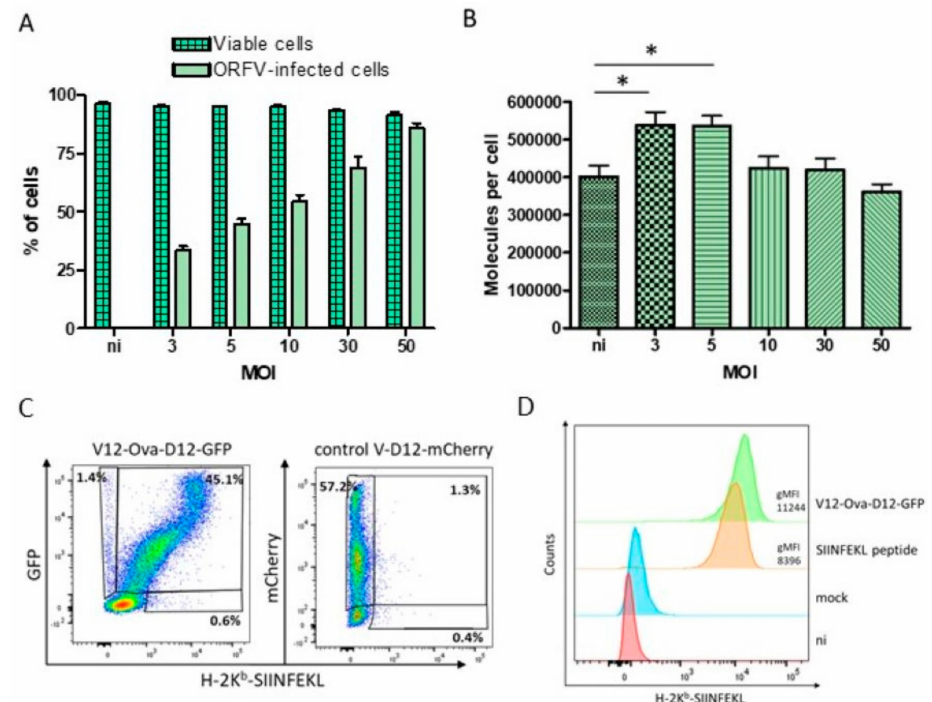
Figure 2. HeLa-K b represent target cells for the identification of ORFV-derived major histocompatibility complex (MHC) class I peptides. ( A ) Cell viability and infection rate following 20 h exposure to ORFV. HeLa-K b cells were infected with indicated multiplicity of infection (MOI). Percentages of viable cells after staining with Zombie Aqua dye and infected cells by mCherry expression were determined by flow cytometry. The data represent the means ± SEM for three independent experiments. ( B ) H-2K b surface expression after ORFV infection with indicated MOI. Twenty hours post infection absolute numbers of H-2K b molecules on the cell surface were determined by flow cytometry using the quantitative indirect immunofluorescence kit. Data shown are means ± SEM from three replicates. ( C , D ) Epitope presentation by HeLa-K b cells. Cells were infected with V12-Ova-D12-GFP or negative control V-D12-mCherry with MOI 5 or loaded with synthetic Ova 257-264 SIINFEKL peptide. Twenty hours after infection cell surface staining was performed using anti-mouse SIINFEKL bound H-2K b antibody followed by flow cytometry analysis. ORFV infection was determined by GFP or mCherry expression. Data are representative of two independent experiments. * p < 0.05; ni, non-infected cells; gMFI, geometric mean fluorescence intensity; Ova,